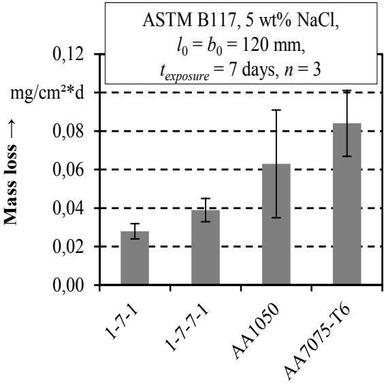
Mass loss after salt spray testing according to ASTM B117 for the multilayered materials 1-7-1, 1-7-7-1 and the alloys AA1050 and AA7075 in as-delivered conditions.